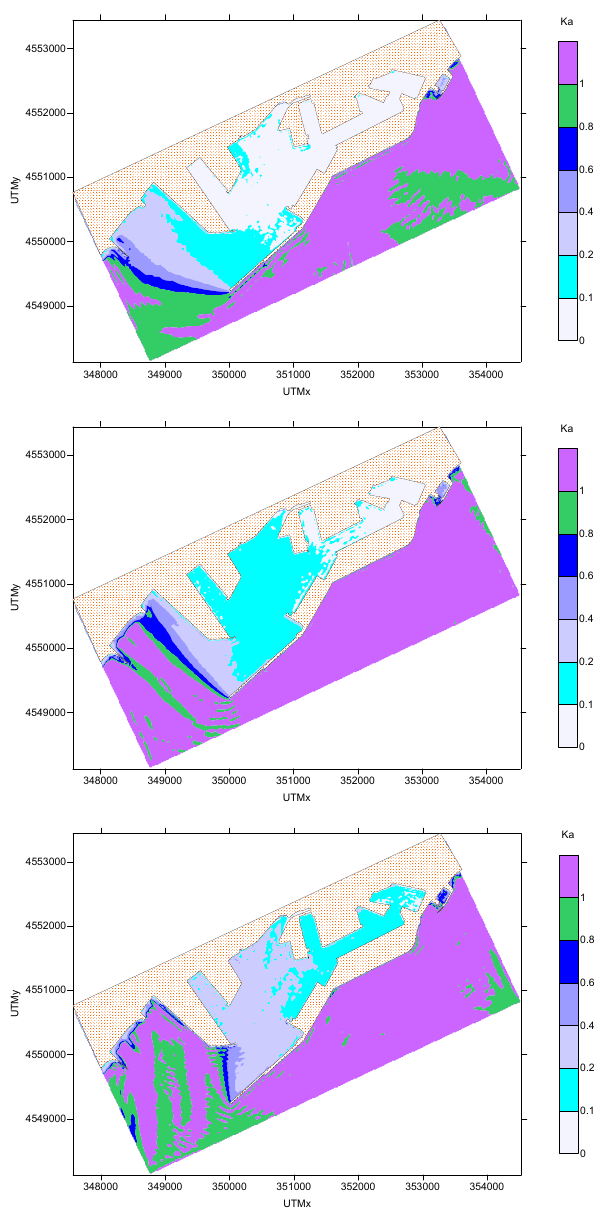
Fig. 14. Maps of agitation coefficients for E (top), SE (centre) and S (bottom)